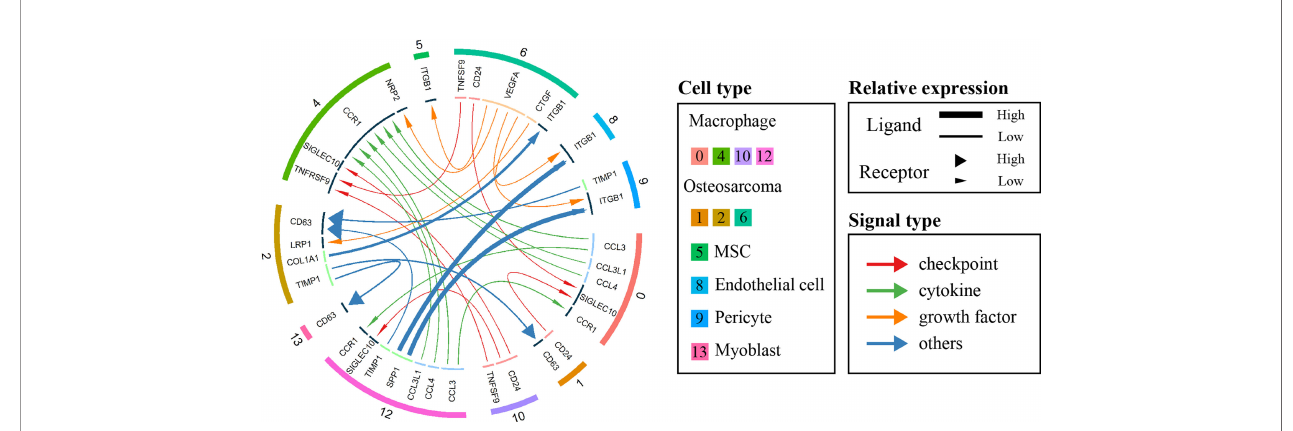
FIGURE 2 | Circos plot showing cellular crosstalk within the OS microenvironment. The outside ring of the circos plot displays cell clusters, and the inside shows the details of each interacting ligand-receptor pair. The lines and arrowheads inside the circos plot were scaled to indicate the relative signal strength of the ligand and receptor, respectively, and different colors and types of lines were used to illustrate various